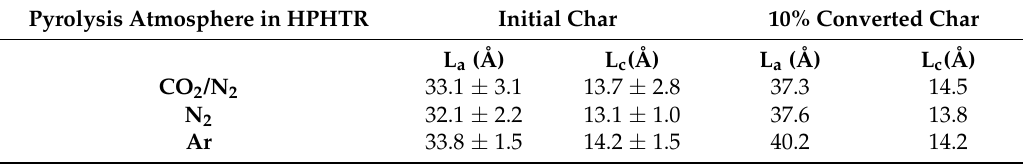
Figure 6 . XRD pattern of chars generated in different pyrolysis atmosphere (before washing with THF). Table 5. Values of L a and L c for chars (before washing with